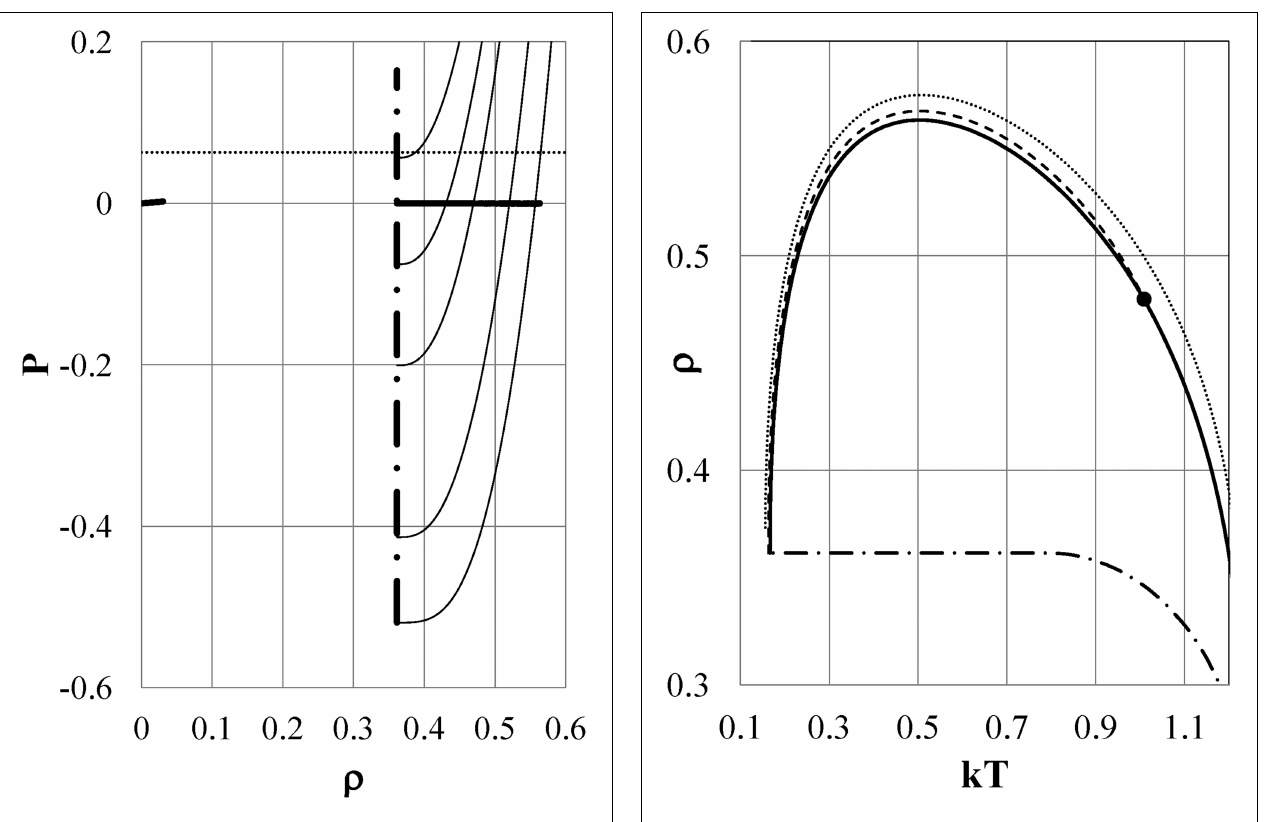
FIGURE 3 | The same as Figure 2 but for kT 5 = 0 . 390, kT 6 = 0 . 260, kT 7 = 0 . 198, kT 8 = 0 . 177, and kT 9 = 0 . 160 from the bottom to the top of the figure, respectively. The binodal line (thick full line) in the liquid phase has a maximum density ρ = 0.5633 and ends at the spinodal line. The spinodal line (dot-dash line : ρ = 0 . 3615) in the liquid phase has a minimum pressure P = − 0 . 5196. All isotherms and the binodal curve overlap with the spinodal curve on the scale of the figure for gas branches.